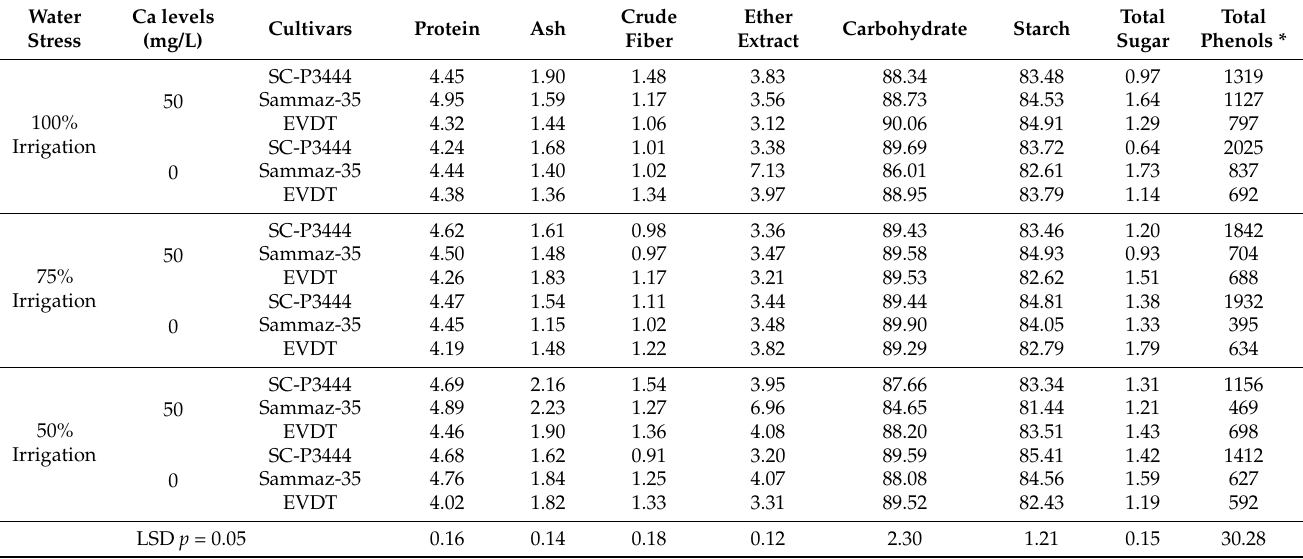
Table 7. Grain chemical contents (g/100 g) as affected by water regimes, calcium level, and cultivars. Water Ca levels Stress